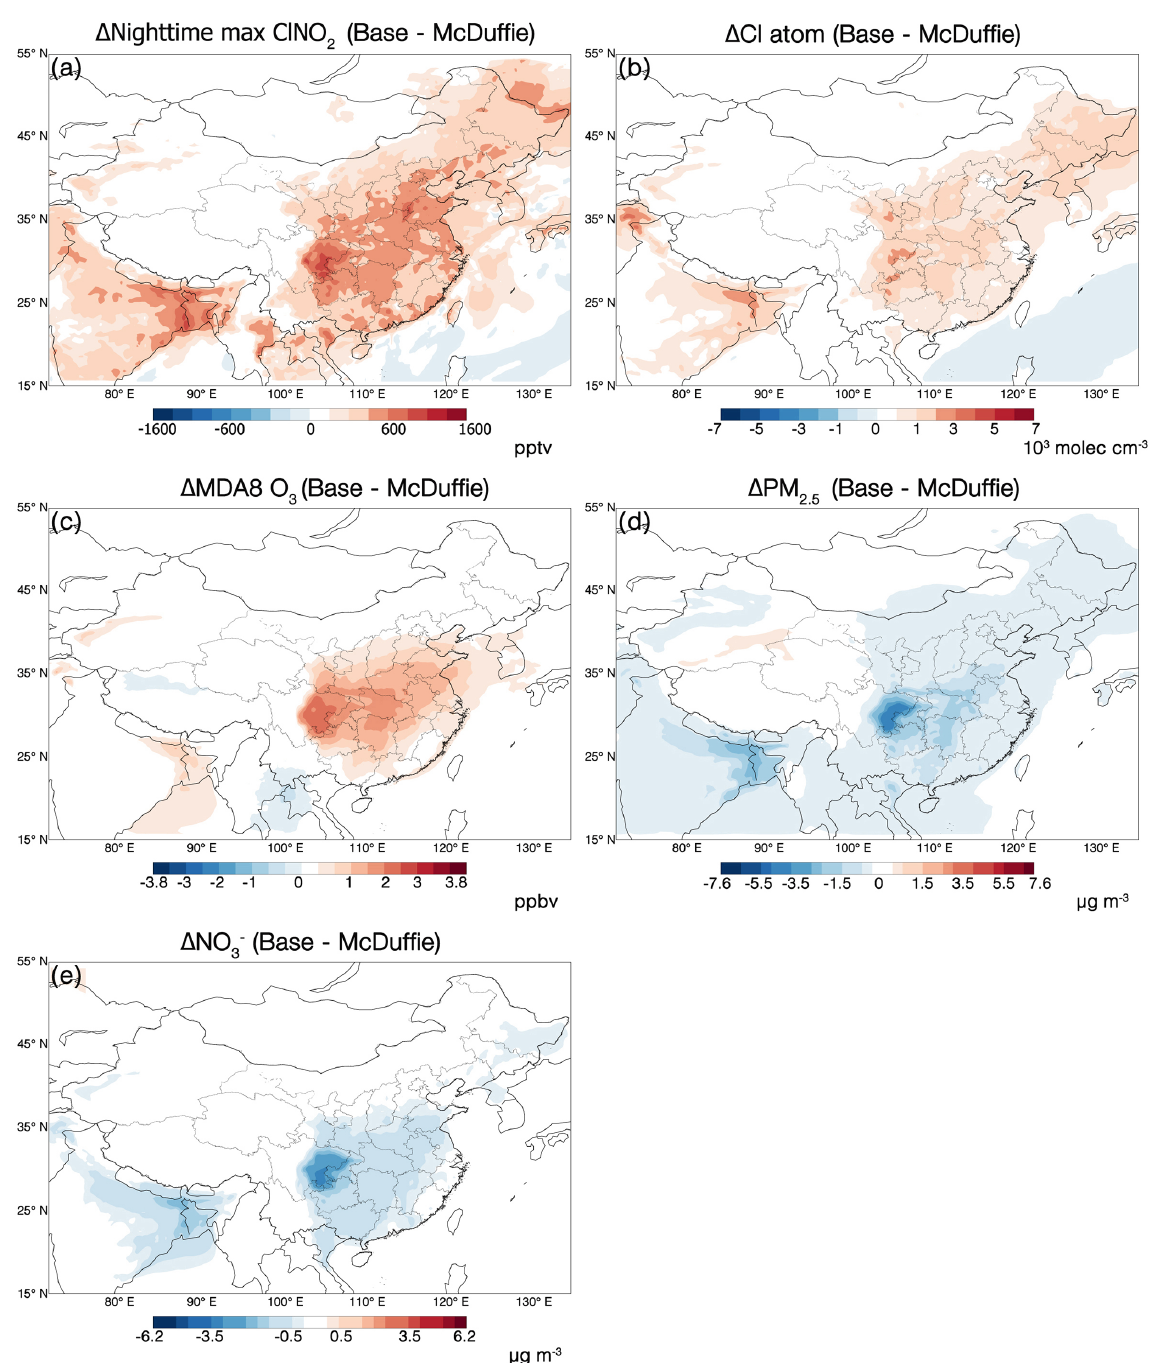
Figure 8. Effects of different parameterizations on annual mean surface concentrations of (a) nighttime max ClNO 2 , (b) Cl atoms, (c) MDA8 O 3 , (d) PM 2 . 5 , and (e) NO − in China, estimated as the differences between the Base and McDuffie 3